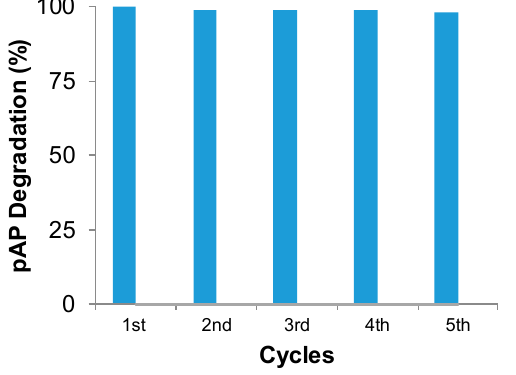
Figure 9. Reuse of FeCO 3 NPs@CALB ‐ Mentha in the degradation of pAP. Reaction conditions were: 3 mg catalyst, 2 mL of pAP solution in distilled water (100 mg/L), room temperature for 3 min.